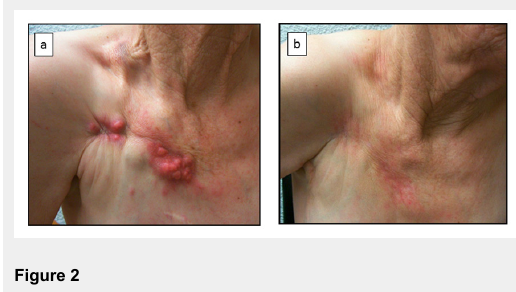
(a) Patient with isolated chest wall recurrence. (b) Complete locoregional response was achieved and sustained after reirradiation and hyperthermia at 2 years after the treatment.